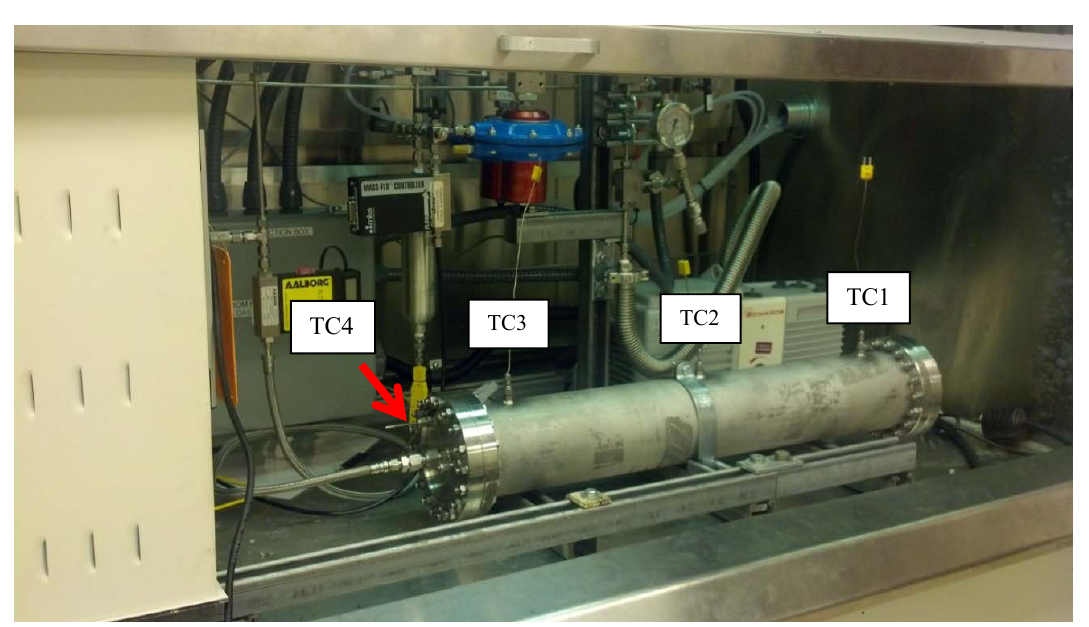
Figure 17. Stainless steel test tube filled with titanium powder and attached to the hydrogenation system. The tube was equipped with four thermocouples